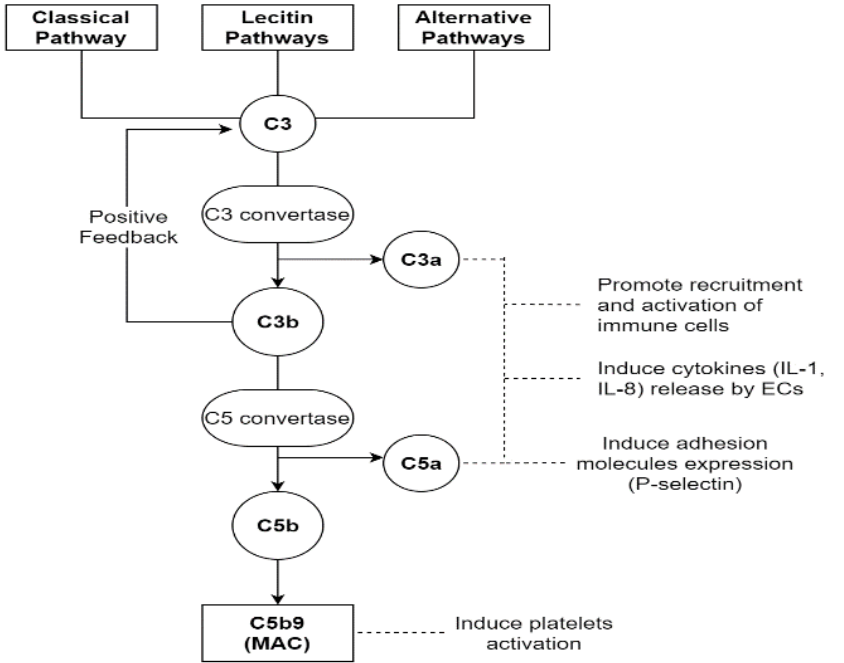
as potentiate thrombin-induced platelet secretion and aggregation, stimulating the tissue factor expression on monocytes through C5b-7 action [13,52] (Figure 2).